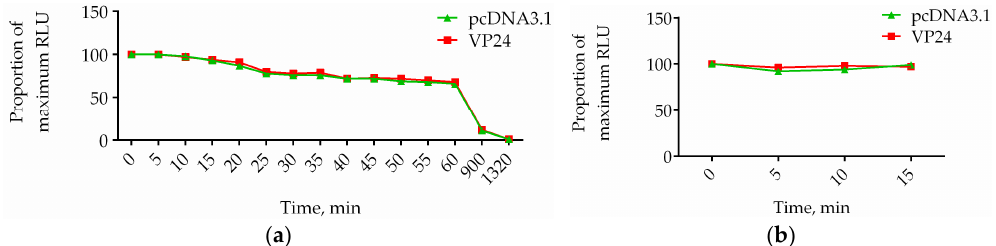
Figure 4. Time ‐ dependent decay of luciferase activity. HEK293T cells cotransfected with pISRE ‐ luc and empty vector or pISRE ‐ luc and VP24 were lysed. ( a ) After addition of D ‐ luciferin, luciferase signal was read over 1320 min. The relative decay is reported by plotting relative light units (RLU) as a proportion of the RLU at t 0 (100%); ( b ) Addition of D ‐ luciferin was performed at 0, 5, 10, 15 min after incubation with luciferase assay buffer. The luciferase signal is reported by plotting RLU as a proportion of the RLU at t = 0 min after addition of luciferase buffer (100%).